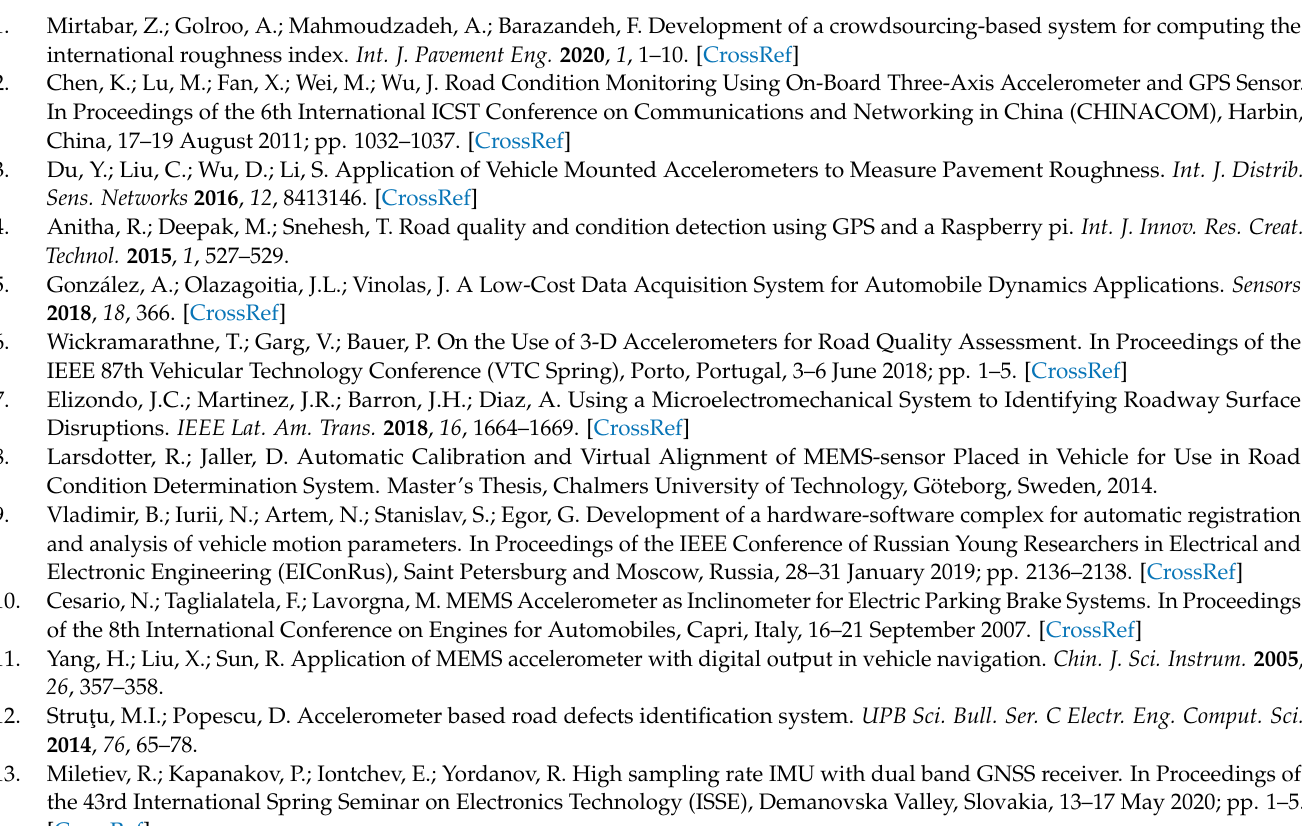
Table S3: Worksheets for evaluation of monitored transport with semi-trailer combination; Table S4: Worksheets for comparison of the influence of different position of sensors on measured values; Table S5: Worksheets for evaluation of events on a monitored route with semi-trailer vehicle combina- tion; Figure S1: Events on a monitored route with semi-trailer vehicle combination; Figure S2: Events on a monitored route with semi-trailer vehicle combination-detail (leg 1–3); Figure S3: Division of the monitored route into